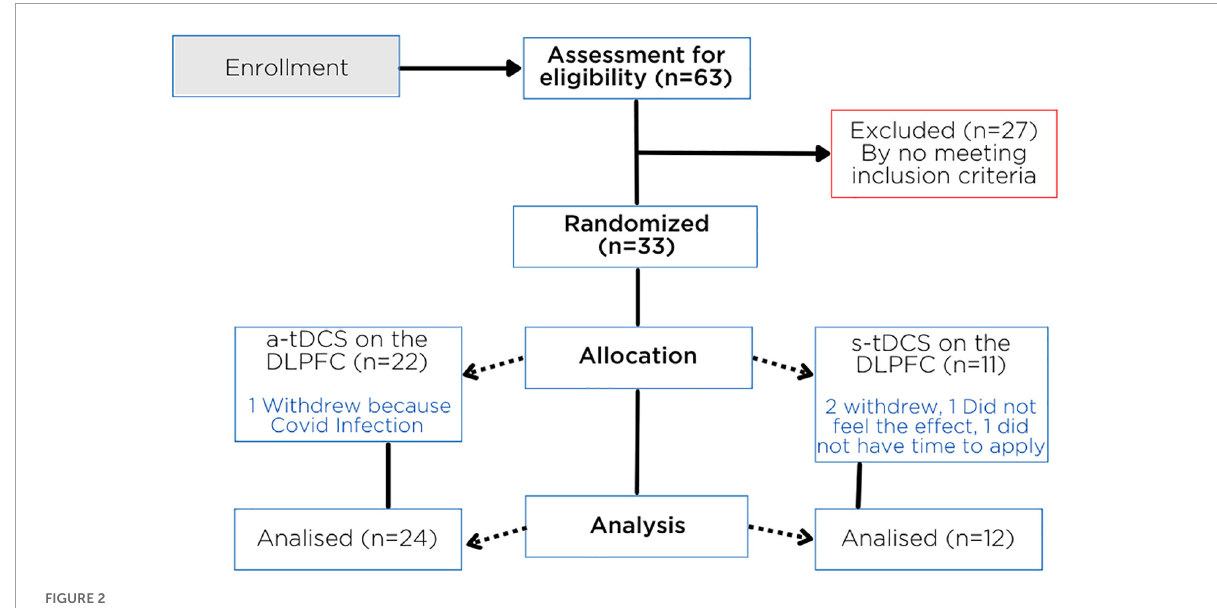
FIGURE2 Flowchart showing randomization, allocation, and progress through the study.